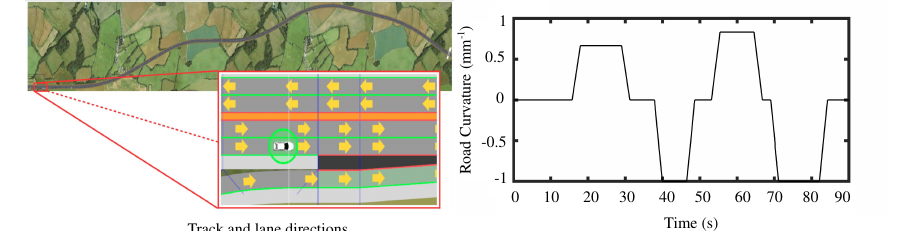
Figure 8. CoCoVeA track and lanes directions along with road curvature of the sections.